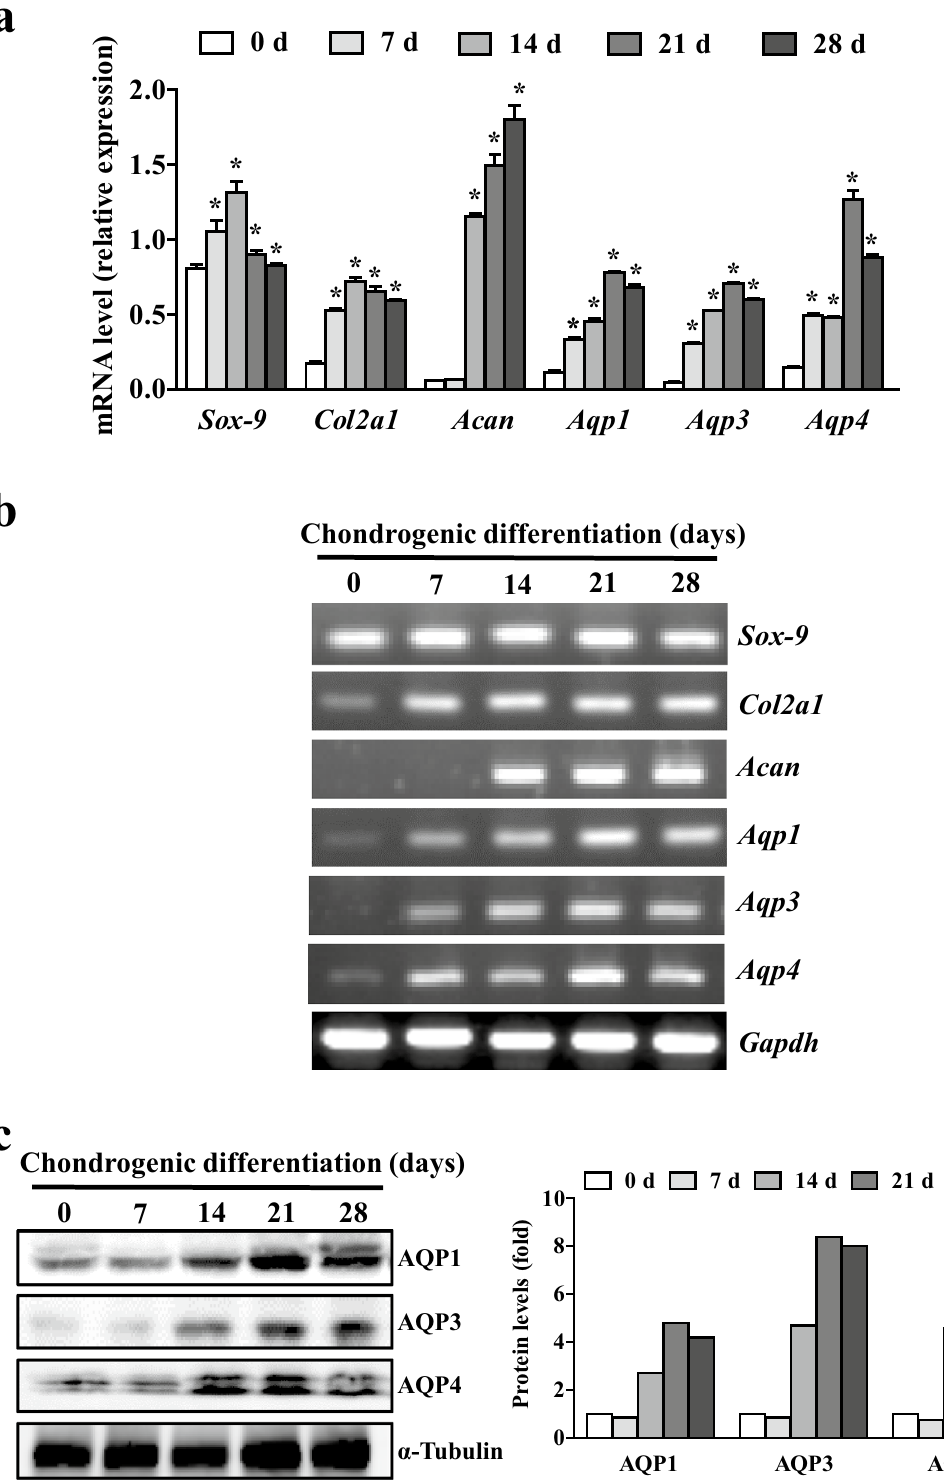
Figure 2. Aquaporin expressions during chondrogenic differentiation of C3H10T1/2 mesenchymal stem cell. ( a ) Expression of AQP1, -3 and -4 mRNA as well as chondrogenic marker genes in C3H10T1/2 mesenchymal stem cell treated with 100 ng of BMP2 for the indicated time periods (n = 4 per each designated time). ( b ) Agarose gel electrophoresis pictures of the PCR products from the transcript analyses of each RT-qPCR result in panel ‘( a )’. ( c ) Western blot analyses for AQP1, -3 and -4 protein expression during chondrogenic differentiation of C3H10T1/2 cells. Densitometric analyses of the western blots are shown on the